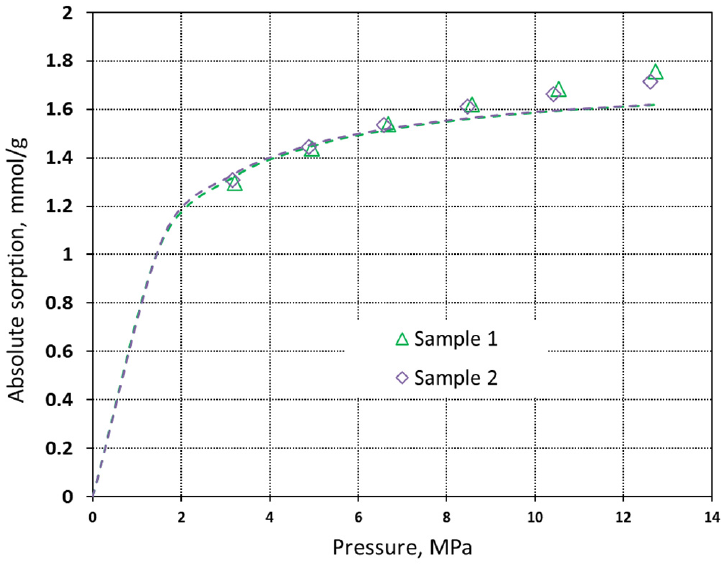
Figure 7. Absolute sorption isotherms of methane on pyrolyzed spruce wood at 40 °C with the Langmuir model fitted (dashed line).